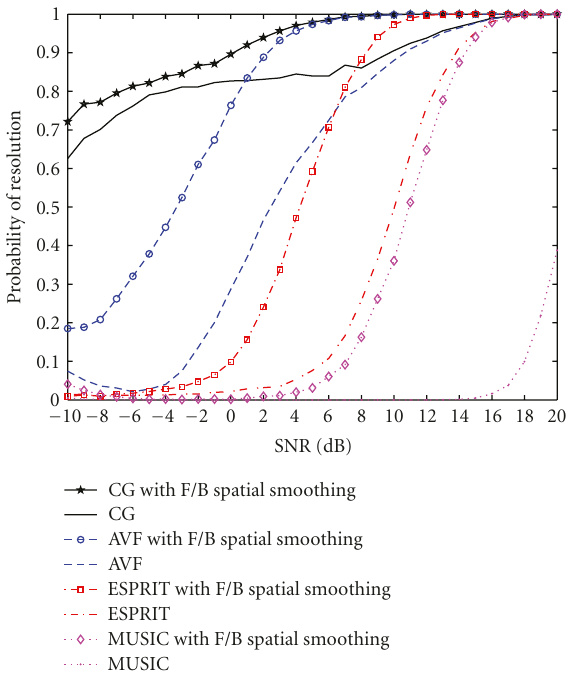
Figure 6: Probability of resolution versus SNR (separation 3 ◦ , K = 50, r = 0 . 9).